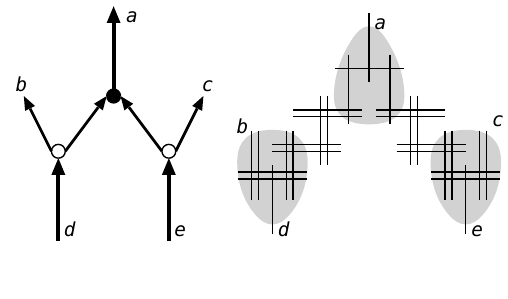
Figure 5. Reduction of thin